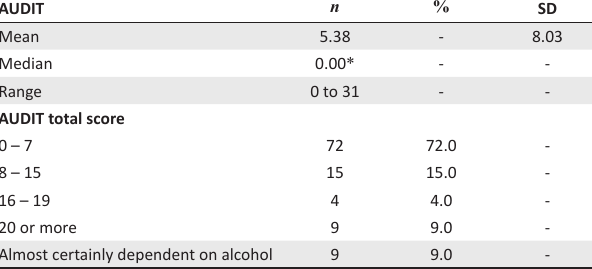
TABLE 1: Alcohol abuse risk defined by the Alcohol Use Disorders Identification Test in Tanzanians with chronic psychotic disorder and suboptimal medication